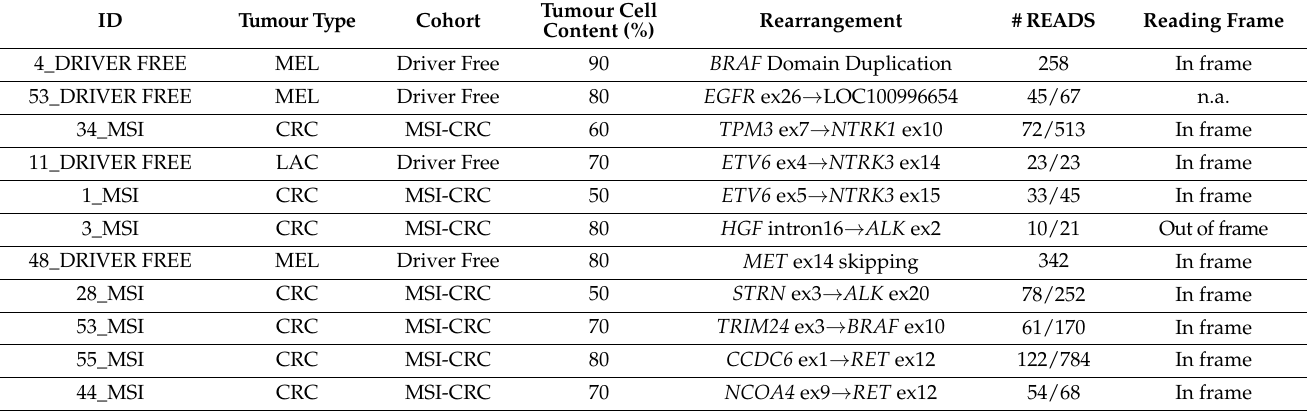
Table 2. Summary of detected gene fusions.